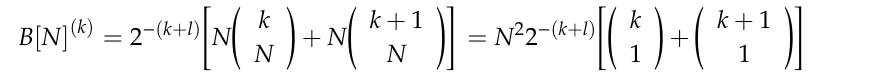
Figure 2. ( a ) The Bondonic graph of chemical bonding by electronic pairing formation; ( b ) The decomposition of bondonic graph as a superposition of active-holes and active hole-particles pairs, respectively.